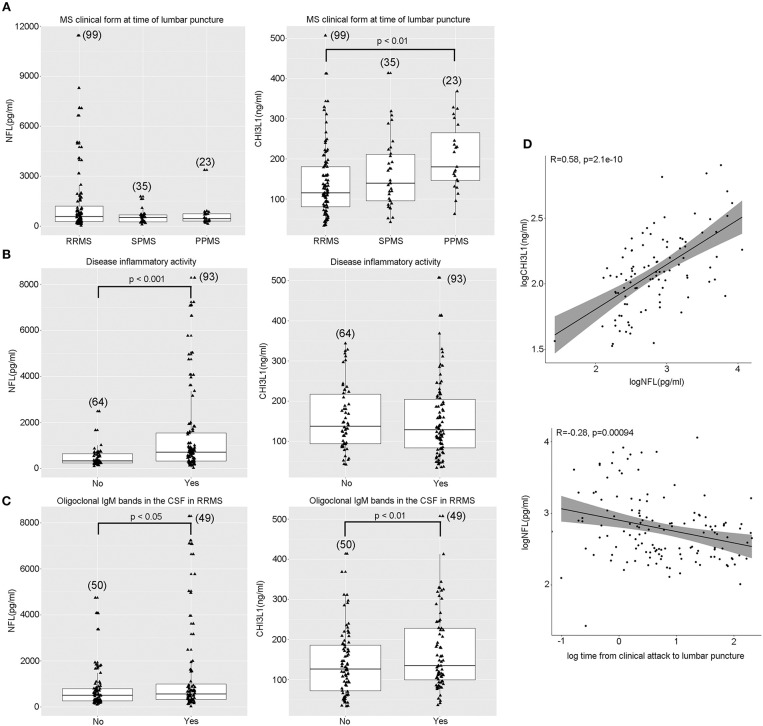
CSF levels of NFL and CHI3L1 in MS in association to phenotype, inflammatory activity, and other influencing variables. (A) Patients with disease activity had higher CSF NFL levels compared to patients without documented disease activity (defined as clinical attack and/or GEL in the MRI within 90 days of CSF collection) (Student T-test p < 0.001). CHI3L1 levels were not different with regards to disease activity (Student T-test p = 0.705). (B) NFL levels were not different between MS forms (ANOVA, p = 0.6) while CHI3L1 were increased in progressive MS compared to RRMS (ANOVA p = 0.01; Bonferroni post-hoc RRMS vs. PPMS p = 0.009). (C) Both NFL and CHI3L1 were higher in the presence of OCMB in the RRMS cohort (Student T-test p = 0.02 and p = 0.004, respectively). (D) NFL and CHI3L1 correlated between each other (Pearson's r = 0.58; p < 0.001) in the RRMS cohort. NFL levels were lower as time from clinical relapse passed (Pearson's r = 0.29; p = 0.04). Sample size for each condition is expressed between brackets in the diagram. Student T-test and correlations were performed with log-transformed NFL and CHI3L1. NFL, neurofilament light chain; CHI3L1, chitinase-3-like-1; RRMS, relapsing-remitting multiple sclerosis; SPMS, secondary progressive multiple sclerosis; PPMS, primary progressive multiple sclerosis. GEL, gadolinium-enhanced lesions; CSF, cerebrospinal fluid; MRI, magnetic resonance imaging.